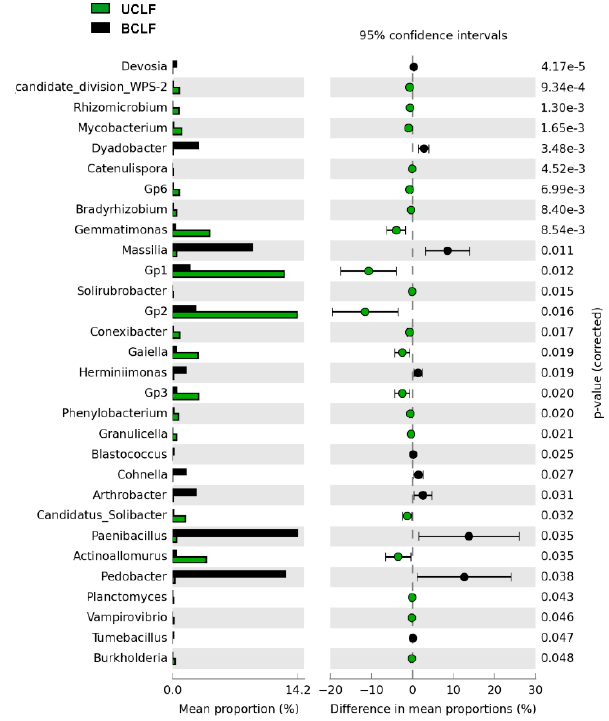
Figure 3. Relative abundance of genera exhibiting significant differences in undisturbed (UCLF) and burnt (BCLF) crest laurel forest soils. t -test at the 95% confidence interval.